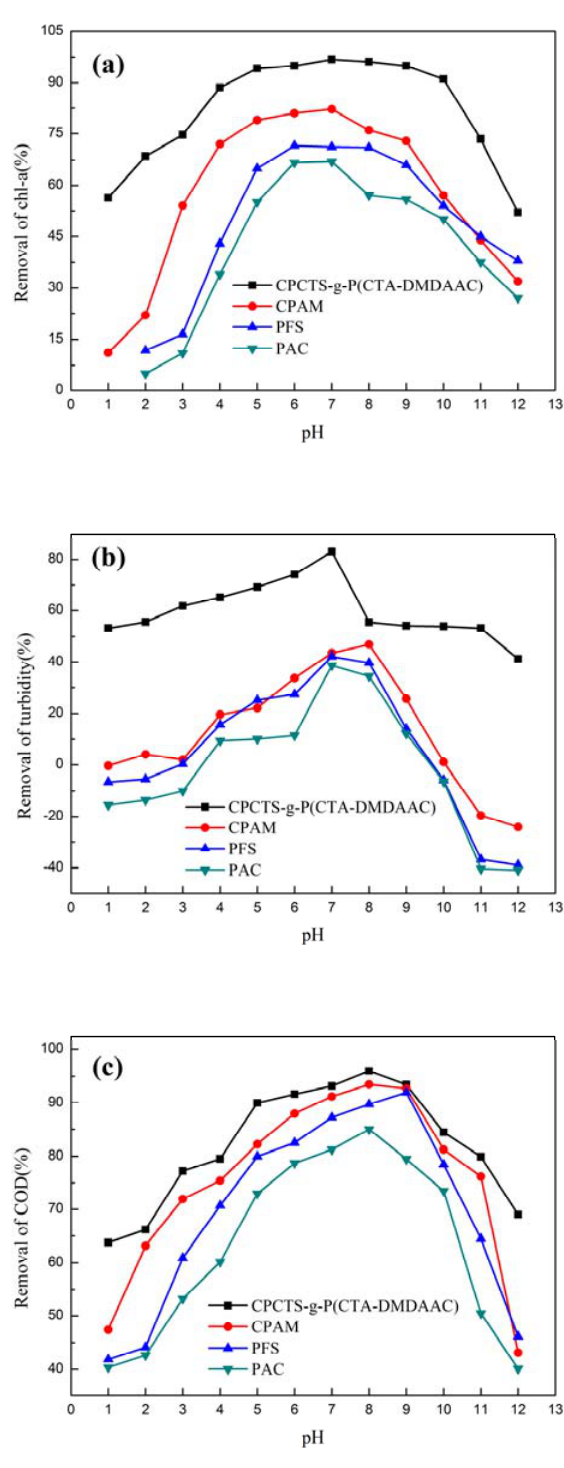
Figure 7. Effect of pH value on flocculation properties: ( a ) Chl-a; ( b ) turbidity; ( c ) COD removal.